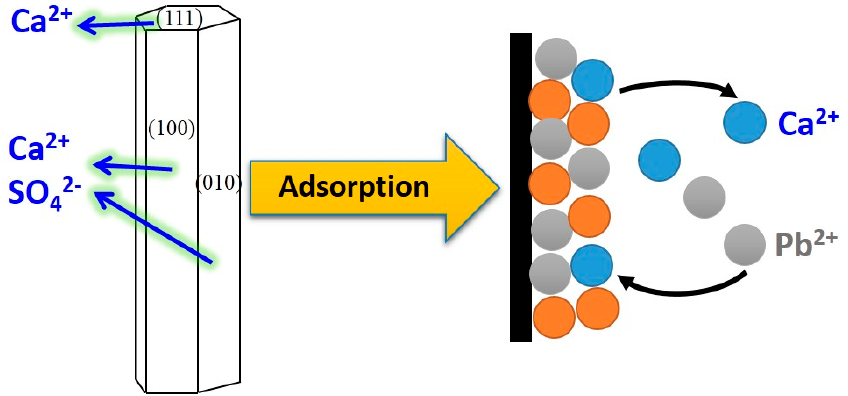
Figure 9. Schematic diagram for the adsorption of lead ions on the CSHW.